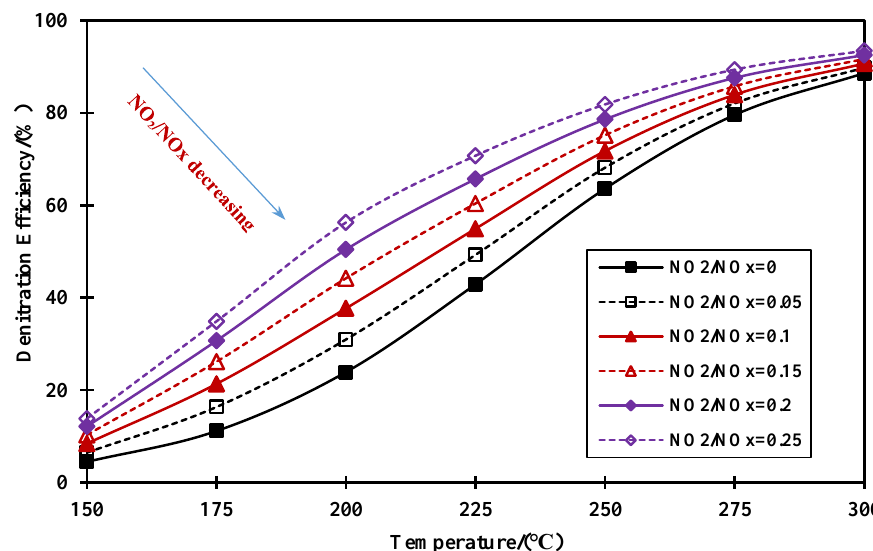
Figure 4. The influence of the reaction temperature and the NO 2 /NO x ratio on the denitration efficiency.